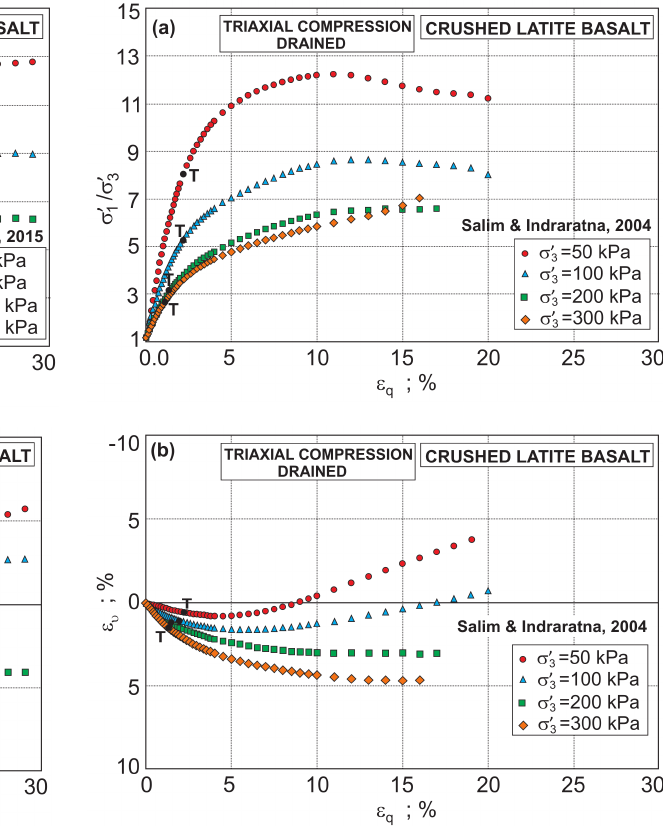
Figure 1: The relationships between stress ratio, volume deformations and shear strain: (a) q εσσ − )( ' 3' 1